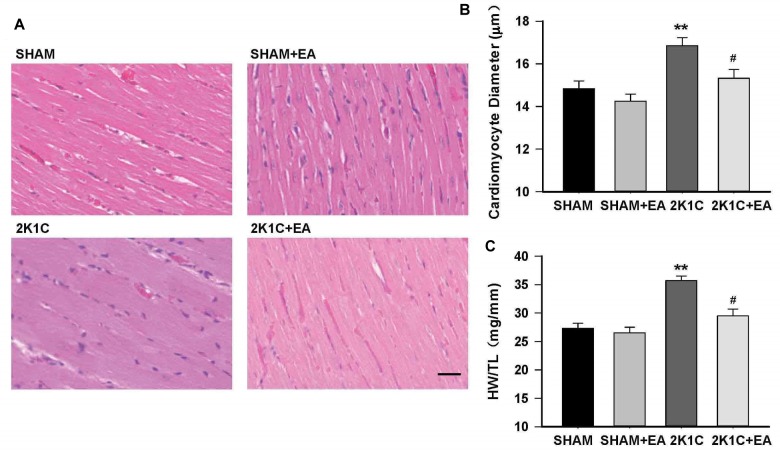
Electroacupuncture treatment protects against cardiac hypertrophy in 2K1C rats. (A) HE stained representative images of left ventricular free wall. (B) Quantification of cardiomyocyte diameter in each group. (C) Heart weight to tibia length (HW/TL) ratio in each group. The scale is 50 μm. Data are presented as mean ± SE; n = 6–8 rats; ∗∗P < 0.01 vs. the SHAM group; #P < 0.05 vs. the 2K1C group.